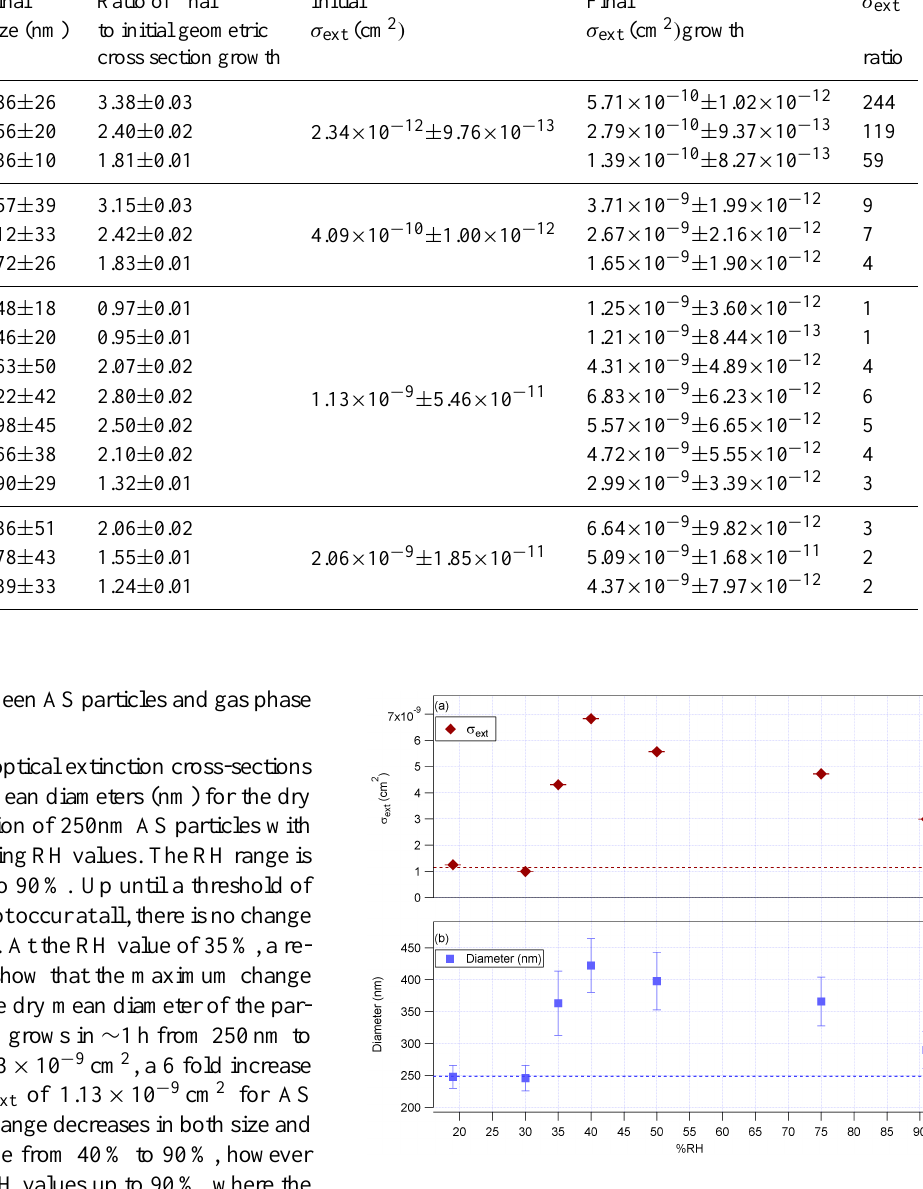
Fig. 2. The results of the ∼ 1 h heterogeneous reaction of AS 250nm particles with gas phase glyoxal at RH values varying from 20% to 90% (while hydrating). (a) The extinction cross sections, σ ext (cm 2 ) (red diamonds). (b) The final mean diameters (nm) (blue